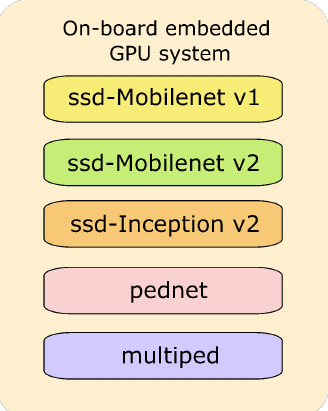
Figure 6. List of deep learning models implemented in the On-board embedded GPU